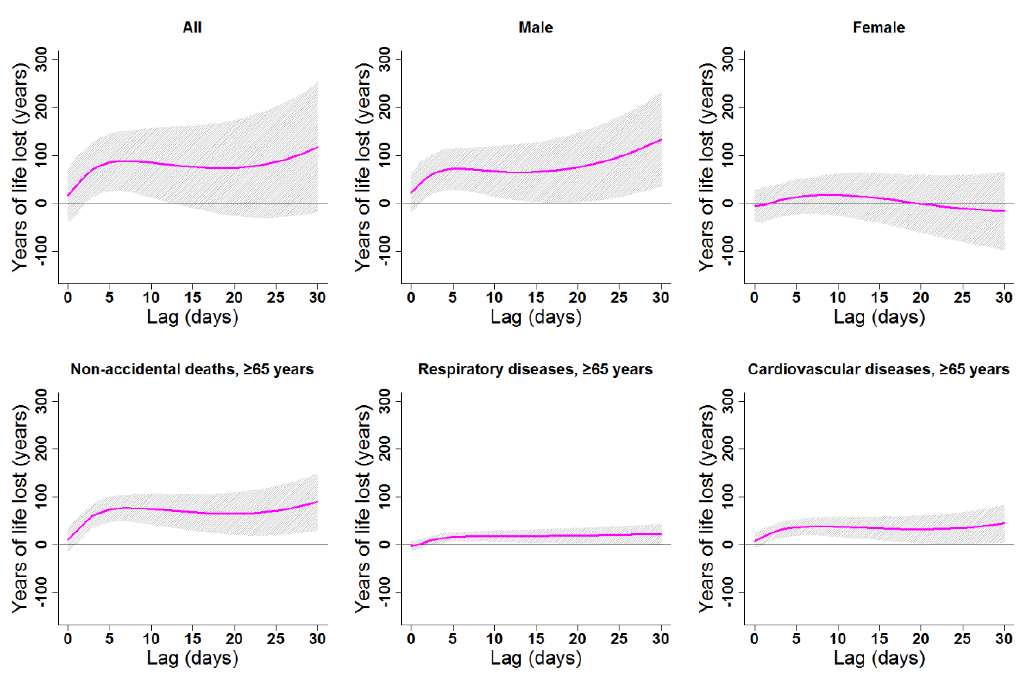
Figure 7. Lag patterns for cumulative heat e ff ects on various subgroups in Lanzhou, China. The bold lines represent the e ff ect estimates, and the grey areas represent 95% confidence intervals. Heat e ff ects in the present study represented changes in YLL caused by higher temperatures from the 75th to the 99th percentile of the overall temperature range. The reference temperature was 19.7 ◦ C (75th